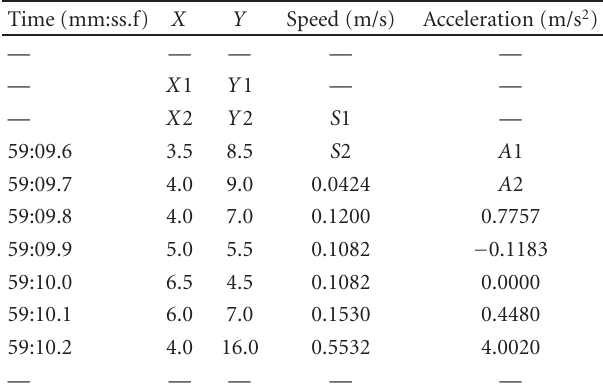
Table 1: An example of the list of raw data, calculated speed, and